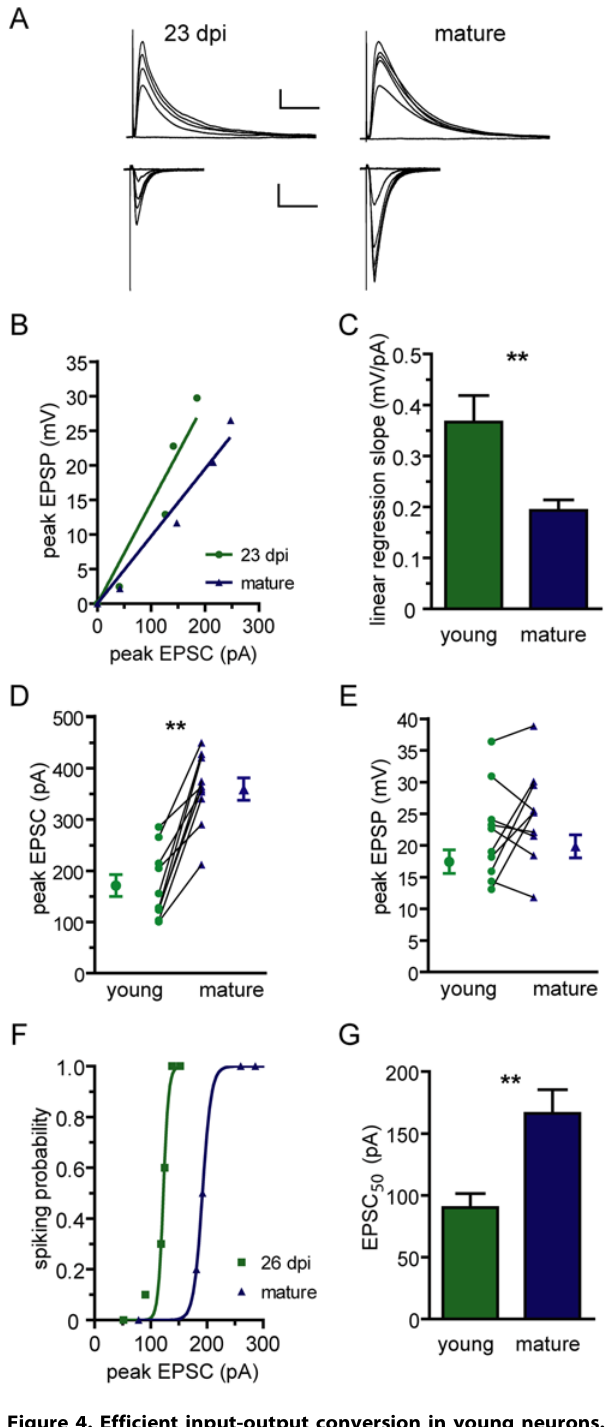
Figure 4. Efficient input-output conversion in young neurons. (A) Typical traces recorded in a young and a mature neuron displaying evoked EPSPs (upper panels) and EPSCs (lower panels) for the same series of increasing stimuli (0.1–1 mA) delivered to the medial perforant path. Scale bars: 5 mV/50 pA, 50 ms. (B) Data from a representative experiment showing EPSP / EPSC pairs and their linear regression curves. (C) Average slope of linear regressions. Statistical difference was analyzed by a two-tailed t -test with Welch’s correction for different variance; (**) denotes p =0.0031, N=40 (both). (D) Simultaneous voltage clamp recordings displaying pairs of EPSC amplitudes evoked by the same presynaptic stimuli. A paired t -test revealed significant differences; (**) denotes p =0.002, with N=10 cell pairs. (E)